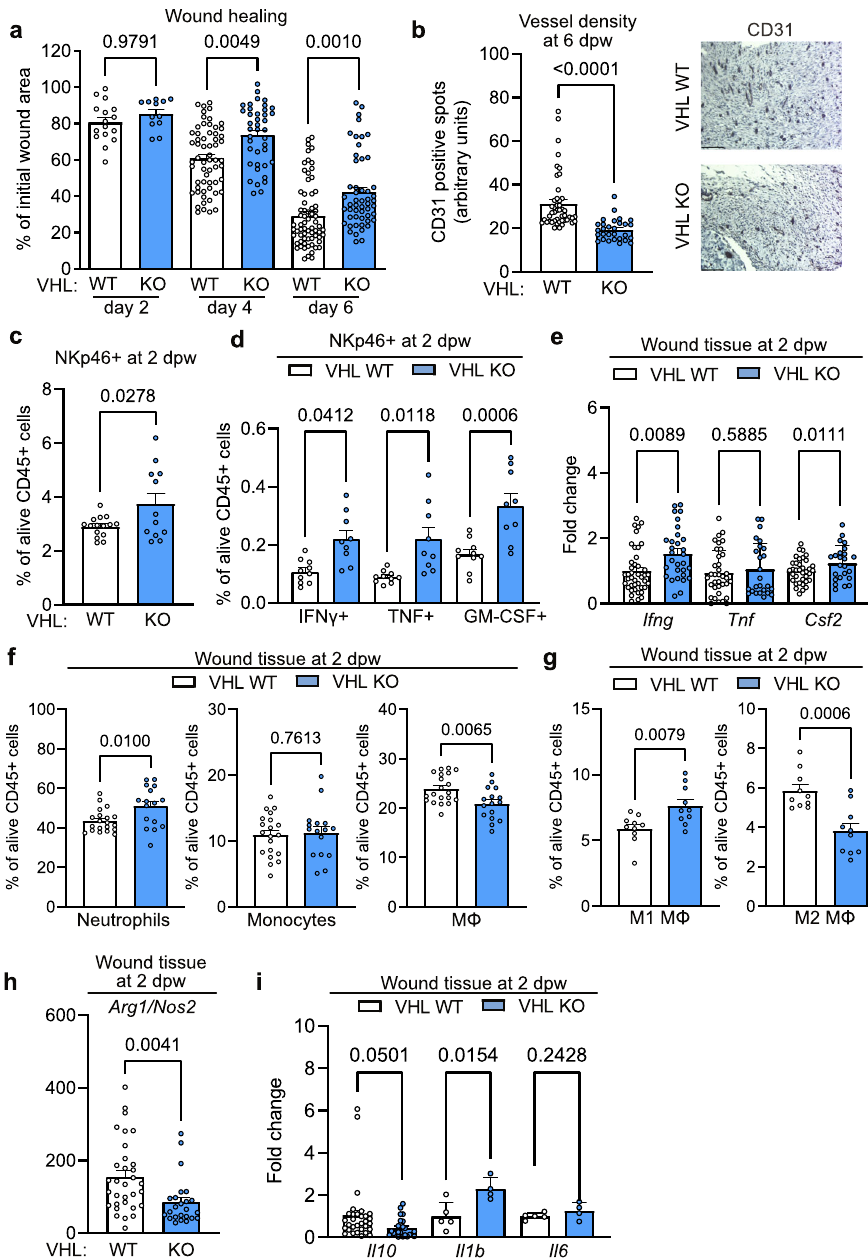
Fig. 3 Constitutive expression of HIF-1 α in NK cells impairs skin regeneration. a Wound areas at 2, 4 and 6 days post wounding (dpw), pooled data of 4 (day 4) and 5 experiments (day 6), (day 2, n = 16 for WT and n = 12 VHL KO; day 4, n = 60 for WT and n = 40 VHL KO; day 6, n = 68 for WT and n = 52 for VHL KO), one-way ANOVA test. b Left, quanti fi cation of CD31 + endothelial cells at 6 dpw ( n = 46 for WT and n = 29 for VHL KO), pooled data of 3 experiments, two-tailed Student ’ s t test. Right, representative images of CD31 immunohistochemistry on skin wounds. Scale bar, 100 μ m. FACS analysis at 2 dpw of ( c ) NKp46 + cells, pooled data of 3 experiments ( n = 15 mice for WT and n = 12 for VHL KO), two-tailed Student ’ s t test, and ( d ) IFN γ -, TNF- and GM-CSF-expressing NKp46 + , NK1.1 + cells, pooled data of 3 experiments ( n = 10 mice for WT and n = 9 for VHL KO), two-tailed Student ’ s t test. e Gene expression of Ifng, Tnf and Csf2 at 2 dpw, pooled data of 3 experiments ( Ifng , n = 40 wounds for WT and n = 30 for VHL KO; Tnf n = 38 for WT and n = 30 for VHL KO; Csf2 , n = 38 for WT and n = 30 for VHL KO), two-tailed Student ’ s t test. f FACS analysis at 2 dpw for neutrophils (CD11b + , Ly6G + ), monocytes (CD11b + , Ly6C + ), macrophages (CD11b + , Ly6C + , F4/80 + ), pooled data of 3 experiments ( n = 20 mice for WT and n = 16 for VHL KO), two- tailed Student ’ s t test, and g M1 (CD80 + , MHCII + ) and M2 macrophages (CD206 + ), pooled data of 3 experiments ( n = 10 mice), two-tailed Student ’ s t test. h Expression ratio for Arg1 and Nos2 at 2 dpw, pooled data of 3 experiments ( n = 30 wounds for WT and n = 22 for VHL KO), two-tailed Student ’ s t test. i Expression of Il10, Il1b and Il6 at 2 dpw, pooled data of 3 ( Il10 ) and 2 experiments ( Il1b and Il6) , ( Il10 , n = 30 wounds for WT and n = 20 for VHL KO, n = 4 for Il1b and Il6 ), two-tailed Student ’ s t test. Data are mean values±